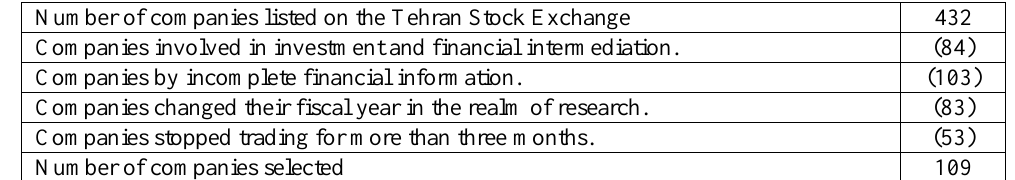
Table 1. Screening conditions of the statistical population during the research period Number of companies listed on the Tehran Stock Exchange 432 Companies involved in investment and financial intermediation. Companies by incomplete financial information. Companies changed their fiscal year in the realm of research. Companies stopped trading for more than three